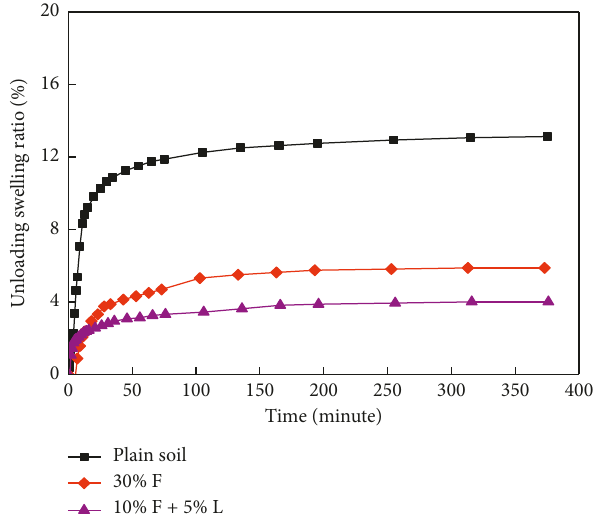
Figure 5: Variation laws of unloading swelling ratio of modified expansive soil over time.